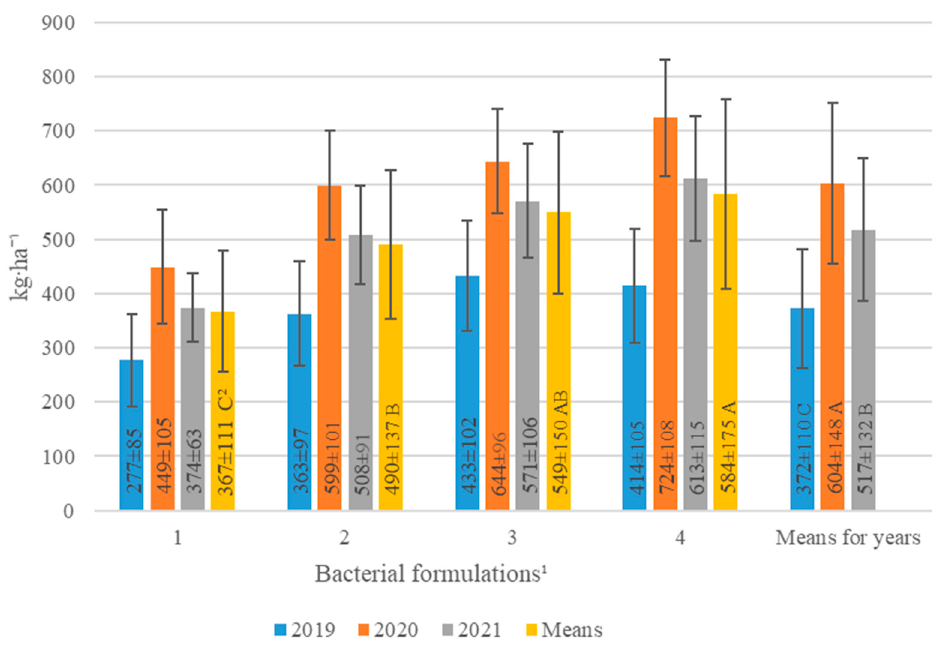
Figure 2. Total protein yield in spring barley grain according to test bacterial formulations from 2019–2021, kg · ha − 1 . 1 For explanations see Table 1. 2 Means for the bacterial formulations and years by the same capital letter (A, B, C) do not differ significantly at p < 0.05. ±, standard deviation.